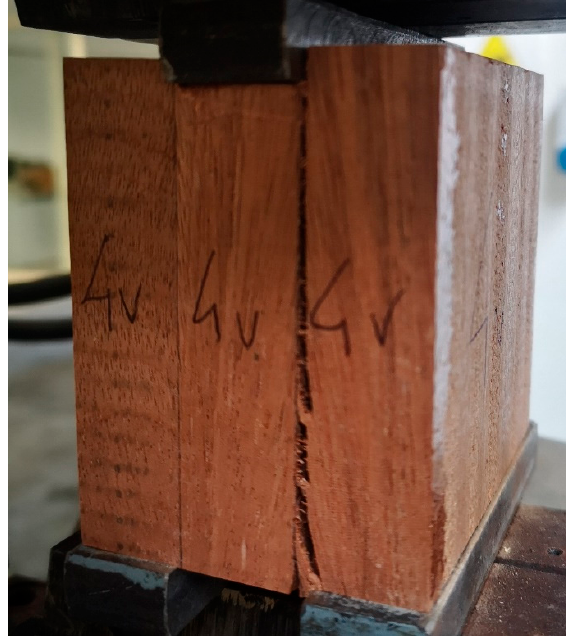
Figure 8. Compression-shear test.